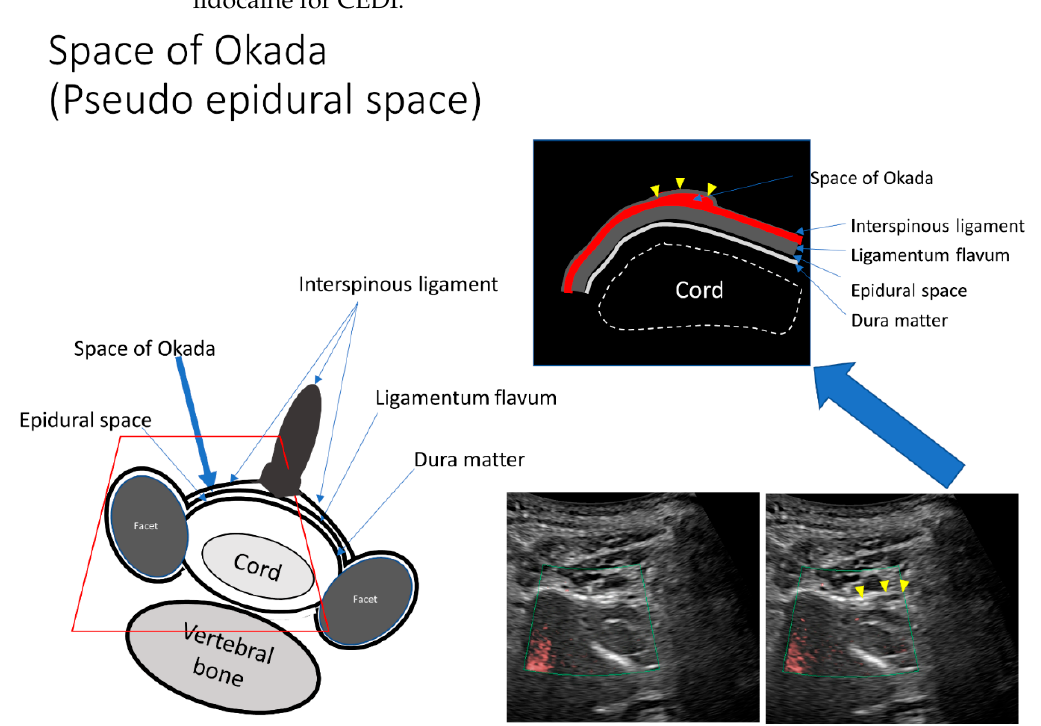
Figure 5. The pseudo-epidural space is enlarged by a small dose of injection. The space between the interspinous ligament and ligamentum flavum, such as the space of Okada, is observed sonographically. If the needle tip is located more superficially than the ligamentum flavum, the injectant will appear in the space of Okada or in the spinalis cervicalis muscle once administered.